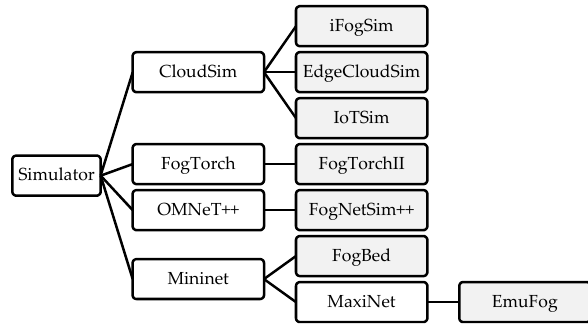
Figure 4. Relations of edge computing simulators.